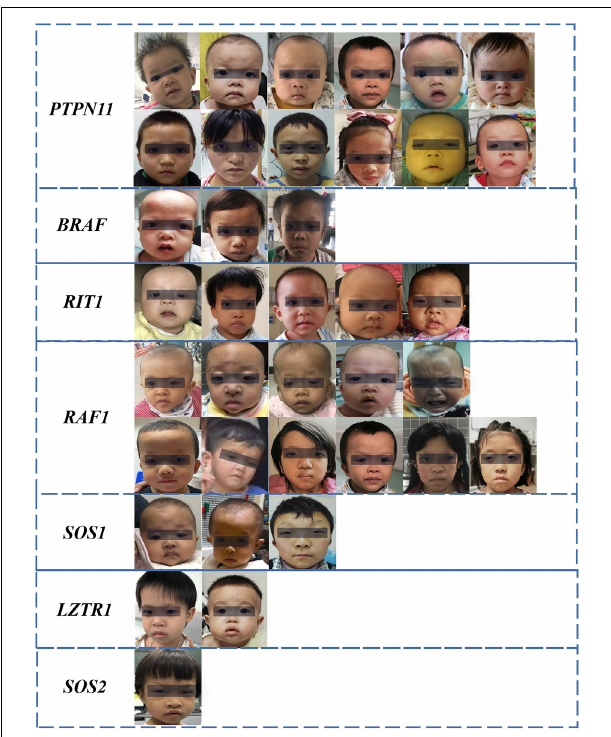
FIGURE 1 | Facial characteristics of NS patients collected from the Guangdong Provincial People’s Hospital, China ( N = 37). The black bar is used to protect privacy.